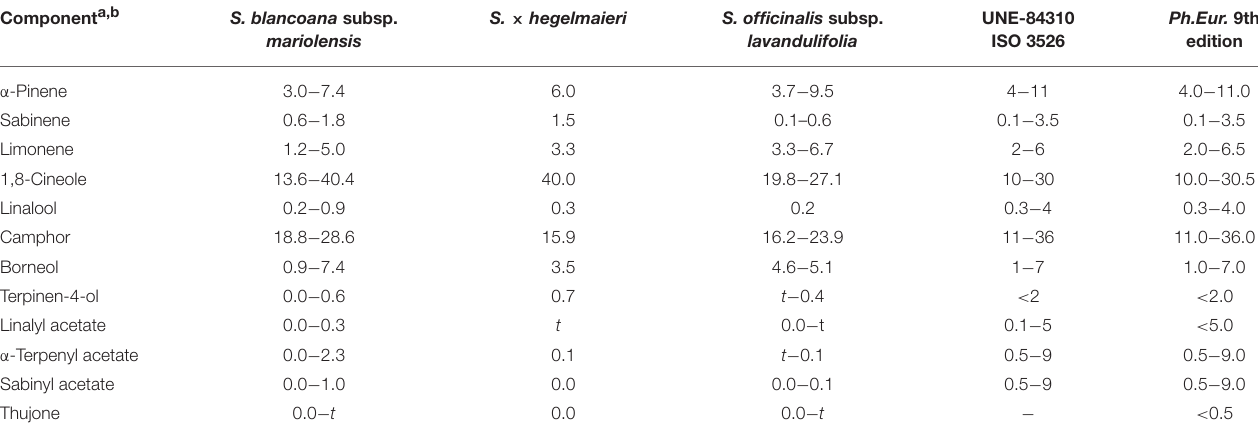
TABLE 5 | Comparison of the composition found for the essential oils from S. blancoana subsp. mariolensis , S. x hegelmaieri and S. officinalis subsp. lavandulifolia to the current requirements for Spanish sage oil in the standards from the European Pharmacopoeia ( EDQM, 2016) (monograph 1849), ISO (2005) (standard ISO 3526) and AENOR (2001) (standard UNE